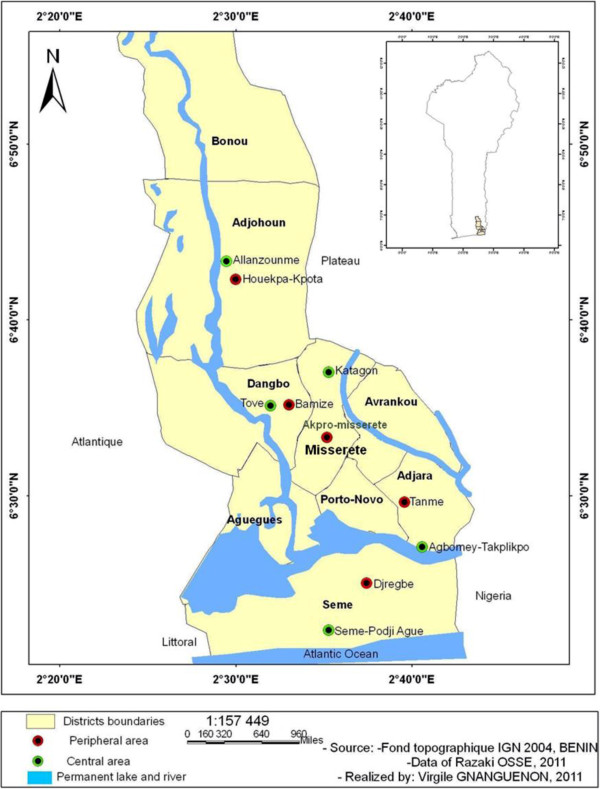
Map of the study area showing localities chosen in central and peripheral areas.